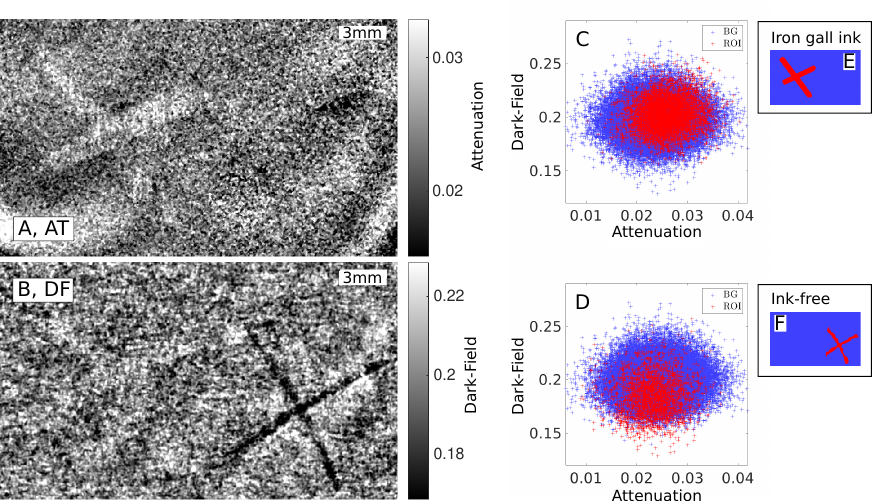
Figure 4. Attenuation ( A ) and dark-field ( B ) image of the sample that features an X written in iron gall ink (on the left side) and a further X written without ink (right side). The scatter plots show the distribution of the attenuation over dark-field values in the ROI (red) and the background (blue). The scatter plot in ( C ) uses the separation mask for the iron gall ink, depicted in ( E ), while the plot in ( D ) uses the separation mask for the ink-free X , shown in ( F